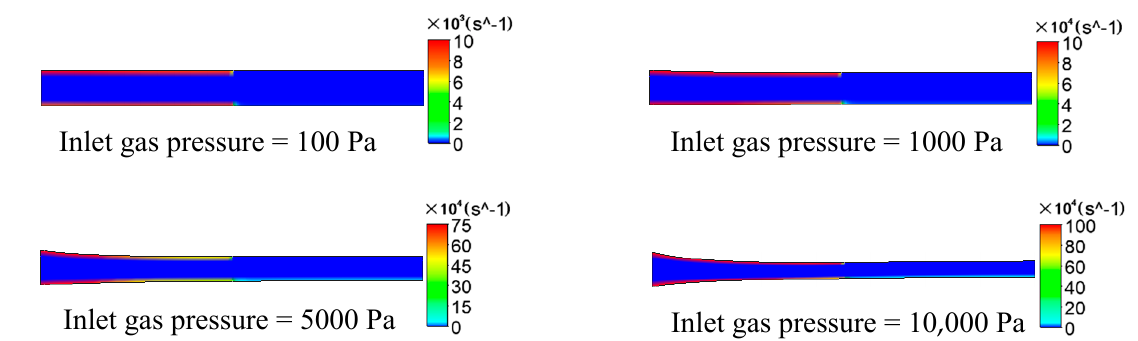
Figure 9. Distributions of the shear rate under different inlet gas pressures.